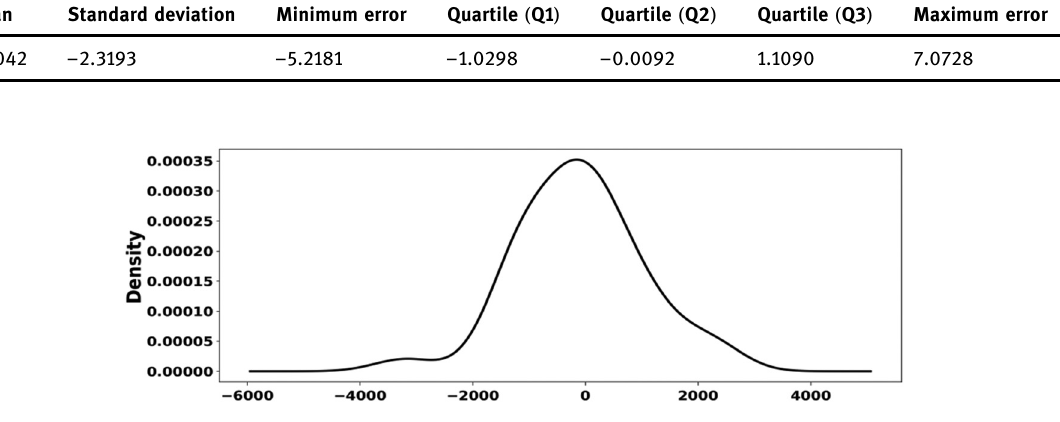
Figure 5: Household electricity consumption residual